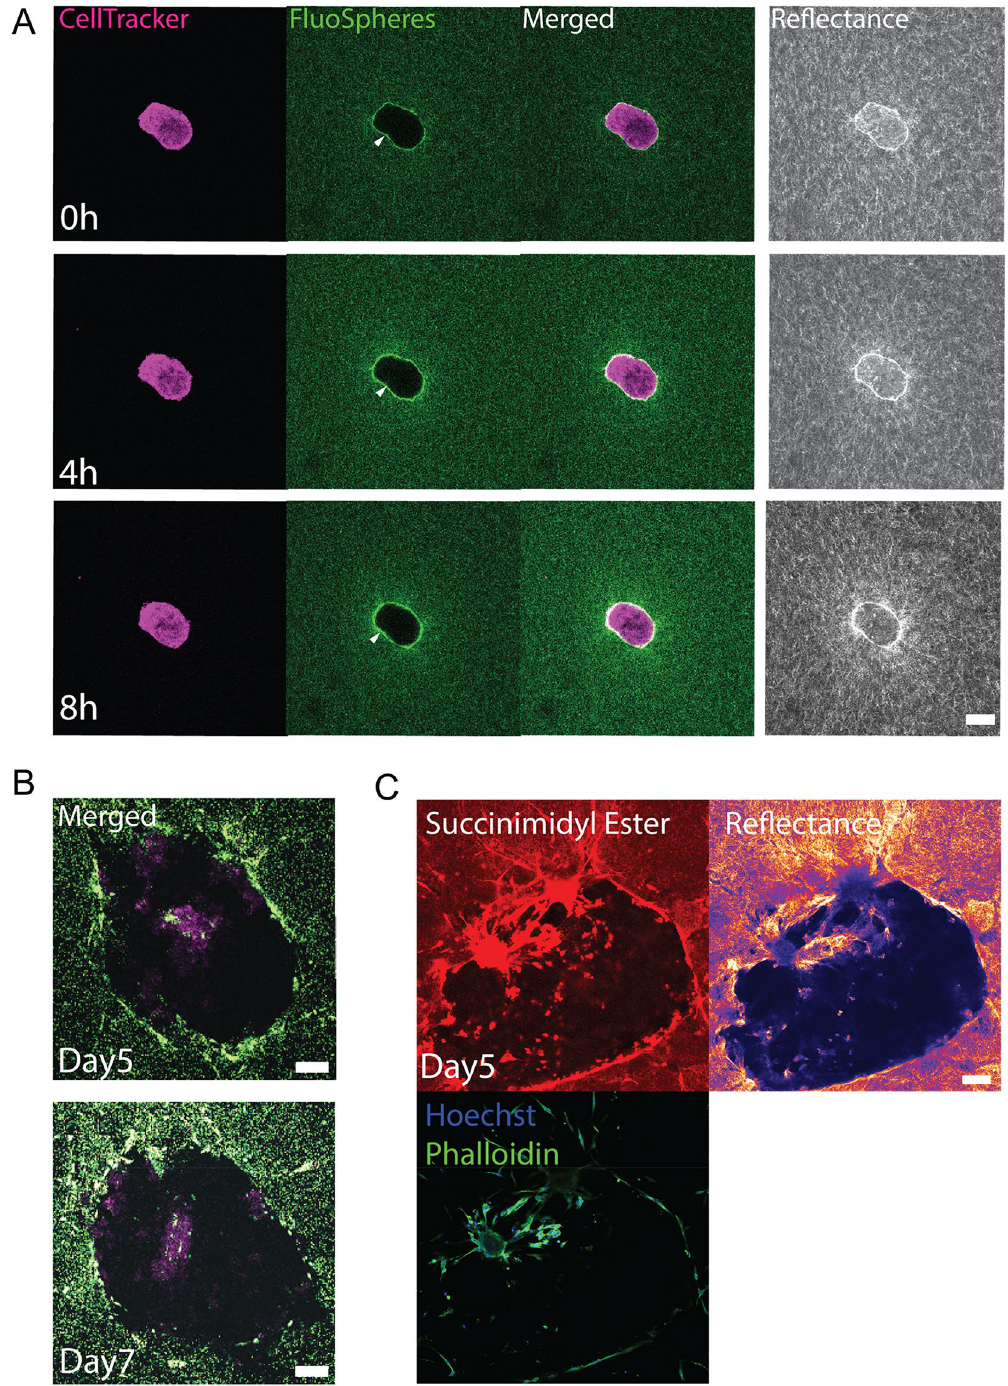
Figure 1. IPF spheroids interact with collagen gels. ( A ) Time series of an IPF spheroid (magenta) treated with TGF-β pulling collagen (green) at 0, 4, and 8 hours after being cultured in collagen gels show collagen densification around the spheroid. (From left to right) Images show spheroid labeled with CellTracker dye, fluorescent microbeads mixed in the collagen gel, merged, and reflectance images taken by confocal reflectance microscopy. ( B ) Representative fluorescence images of an IPF spheroid that is treated with TGF-β on day 5 and day 7. Degradation and rupture of collagen matrix lead to hole formation. ( C ) Representative fluorescence images of an IPF spheroid that has been treated with TGF-β showing that no amine groups (the dark regions that fail to be dyed with fluorescent succinimidyl ester) or visible structures (the dark region in the reflectance image) in the hole on day 5. Scale bars, 100